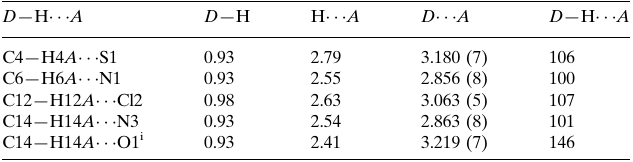
Hydrogen-bond geometry (A˚ , (cid:1)